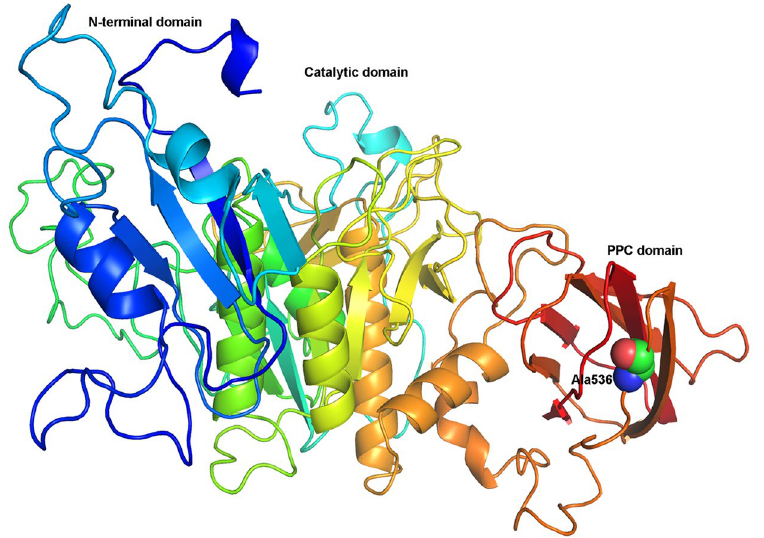
Figure 3. The modeled structure of protease AprA. Structure of serine protease Pro-TK-SP from Thermococcus kodakaraensis (PDB ID: 3AFG) was used as template. The PPC domain is represented in red. Truncation residue is displayed in spheres. Figure was developed using Pymol 0.99.